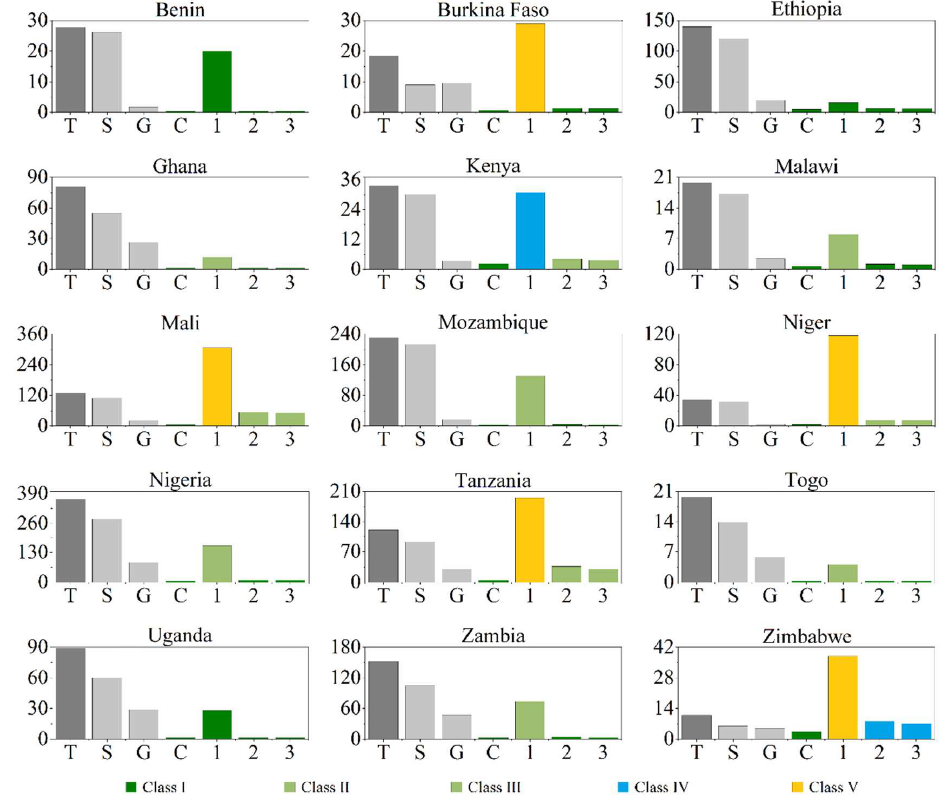
Figure 3. Water resources versus water consumption in the 15 different countries. T—total available annual renewable water resources; S—annual renewable surface water; G—annual renewable groundwater; C—current annual water consumption (includes domestic, industrial, and irrigation), 1—annual water consumption in scenario 1; 2—annual water consumption in scenario 2; 3—annual water consumption in 3. The Y -axis represents the water volume in 10 9 m 3 .